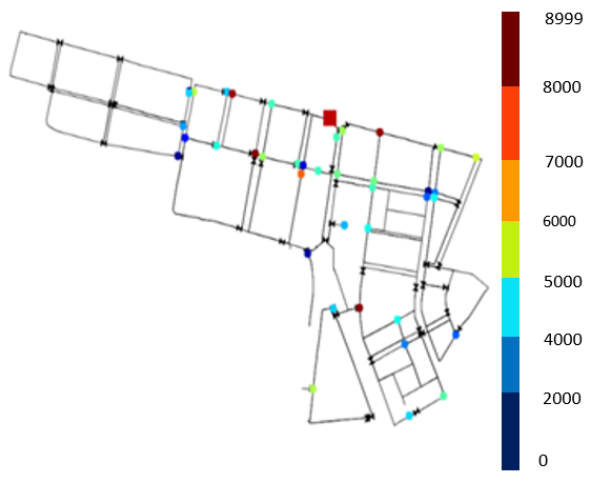
Figure 6. Estimated impact for contaminant occurred at water source (Reservoir).